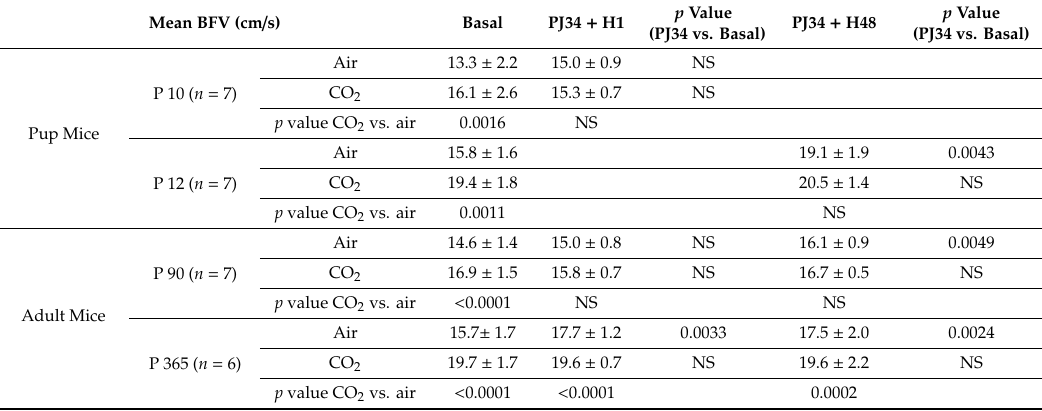
Table 2. Mean blood flow velocities recorded in the basilar trunk in control (naive) and PJ34-treated mice at di ff erent developmental stages under air and / or 5% CO 2 - 16% O 2 - 79% N 2 . Mean BFV (cm / s) Basal PJ34 + H1